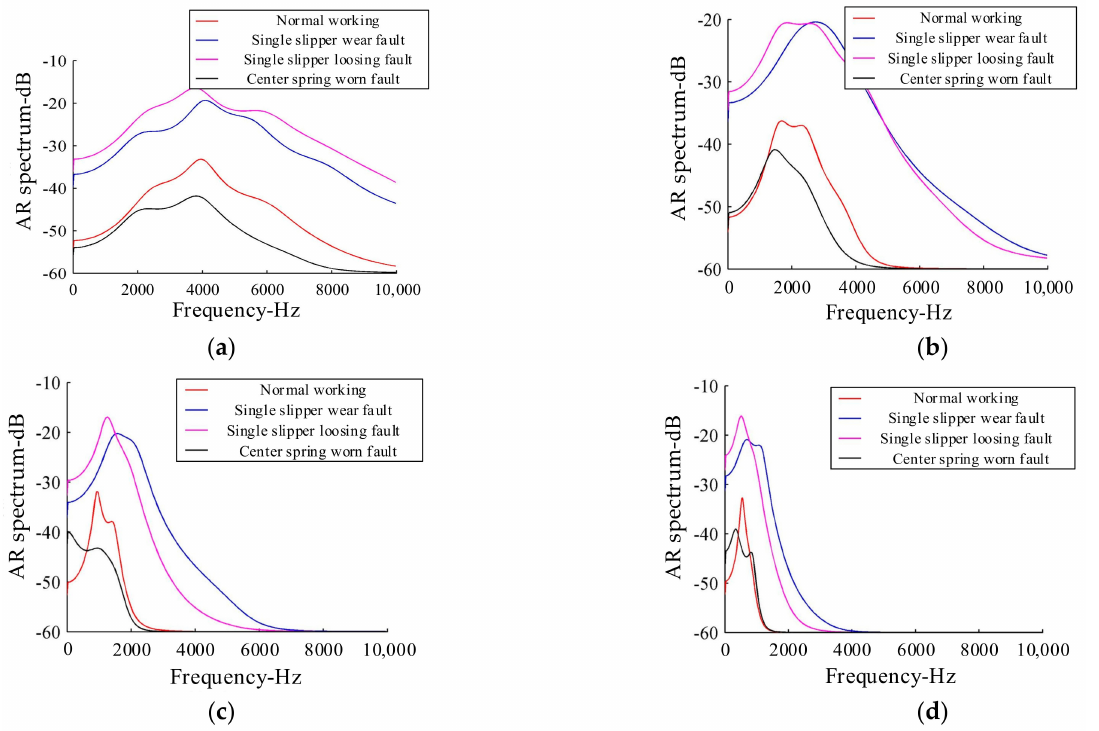
Figure 13. Autoregressive (AR) power spectra of the first four order IMF components: ( a ) IMF 1; ( b ) IMF 2; ( c ) IMF 3; and ( d ) IMF